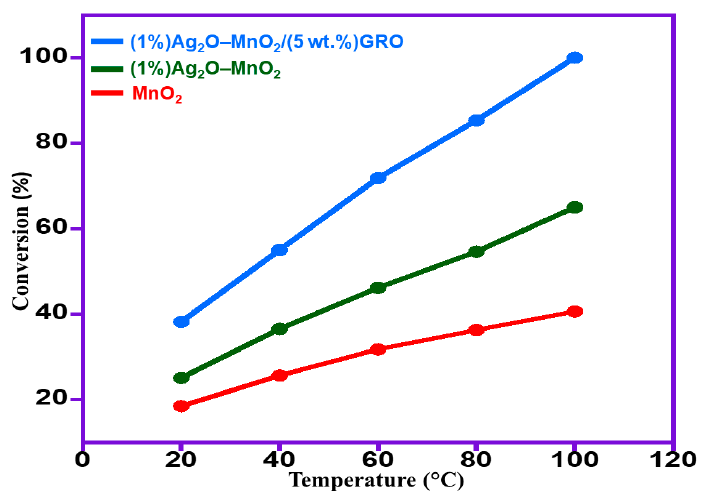
Figure 9. Impact of temperature on the benzyl alcohol (BnOH) conversion using various catalysts.